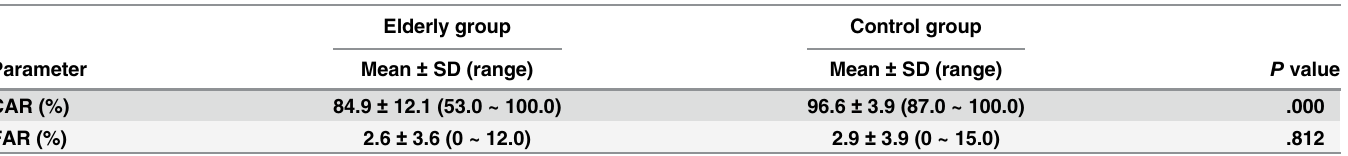
Table 2. Results of the VFIT-EV.